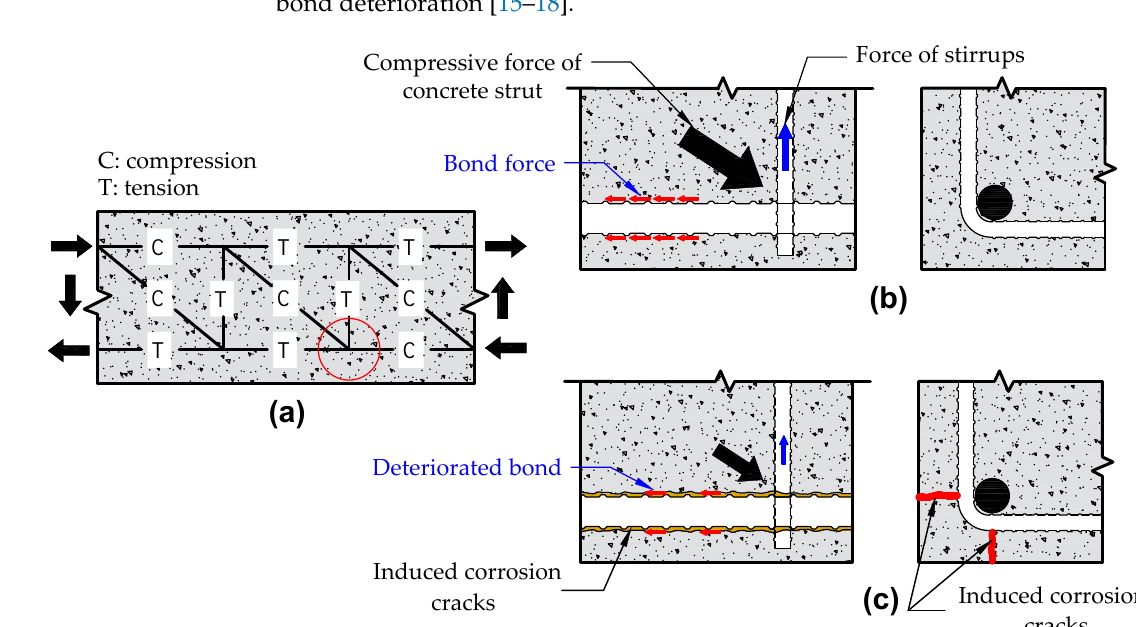
Figure 1. Importance of bond in truss mechanism: ( a ) truss mechanism; ( b ) equilibrium force at the circled point in ( a ); ( c ) equilibrium affected by bond degradation due to induced corrosion crack.